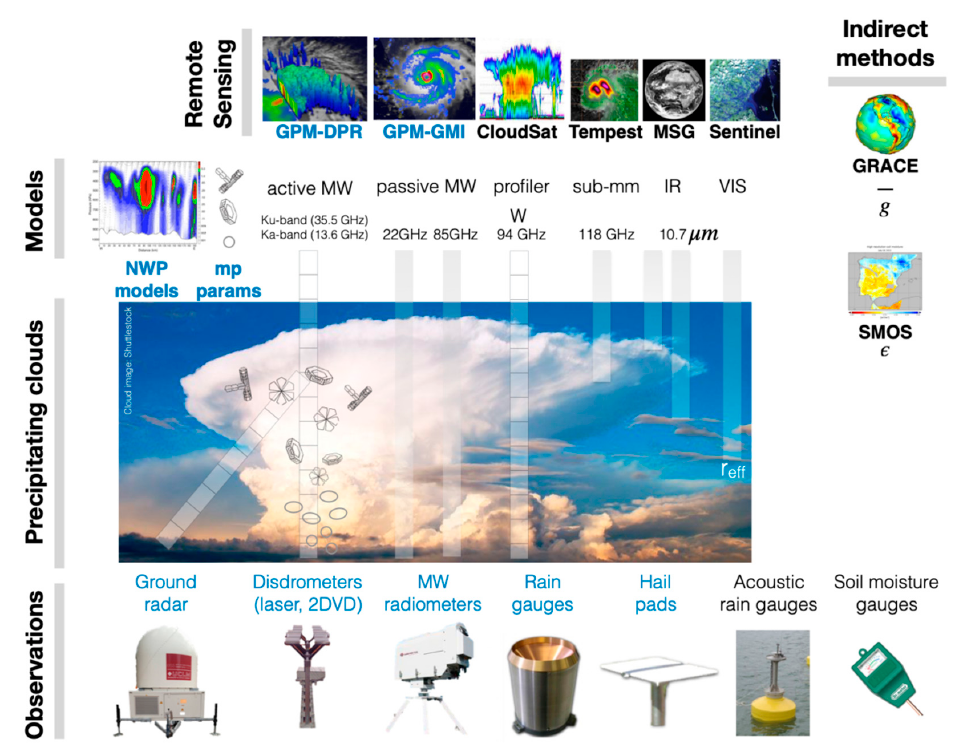
Figure 1. An overview of the main aspects of precipitation science in 2021.